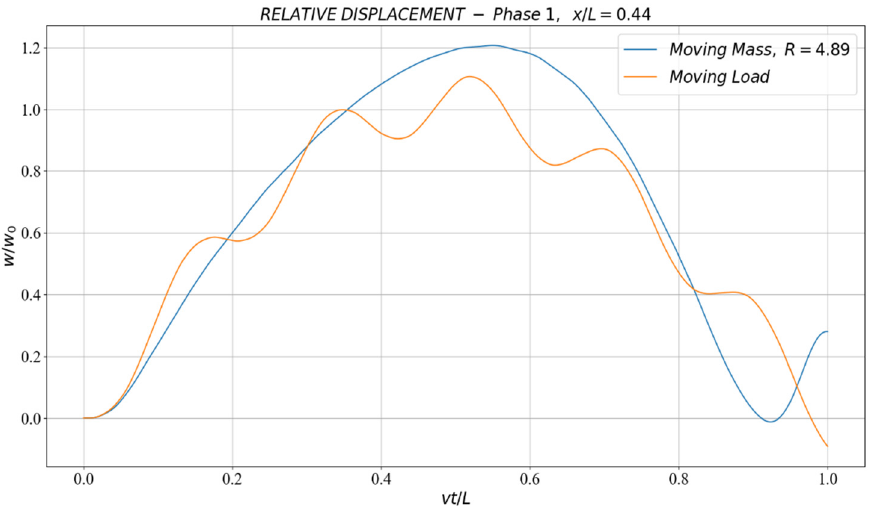
Figure 6. Forced vibration time history of the deck displacement at station x = 7L/16 of the bridge for a heavy m = 500 kg mass traversing at a high speed of v = 10.0 m/s.